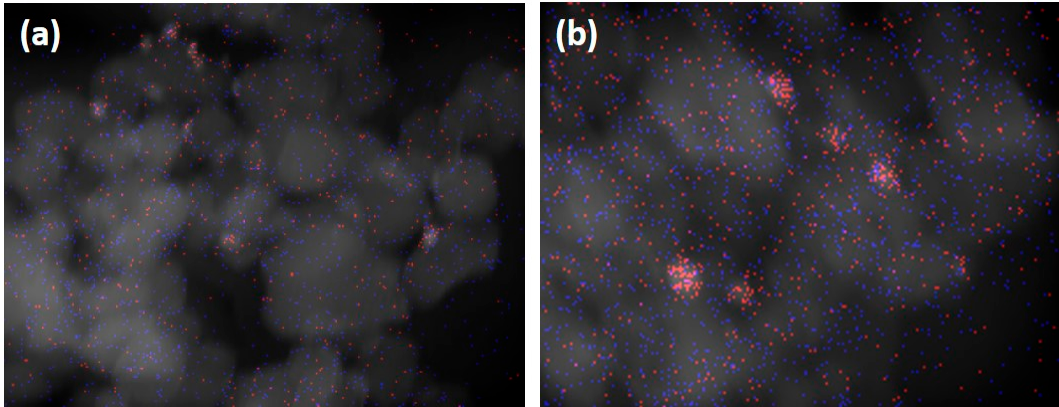
Figure 3. EDS mapping of the distribution of platinum (red) and tungsten (blue) in the Pt–W[x]/TiO 2 catalysts: ( a ) Pt–W[3]/TiO 2 and ( b ) Pt–W[7]/TiO 2 .